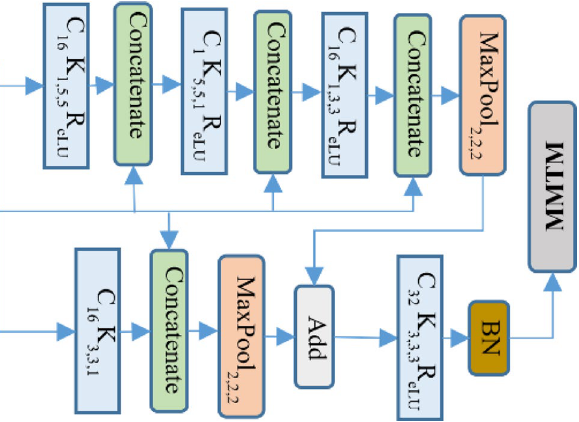
Figure 6. Detailed overview of the dense residual block of the audio and video slow–fast network (the first block of video network is illustrated here). The symbol description is similar as in Fig.